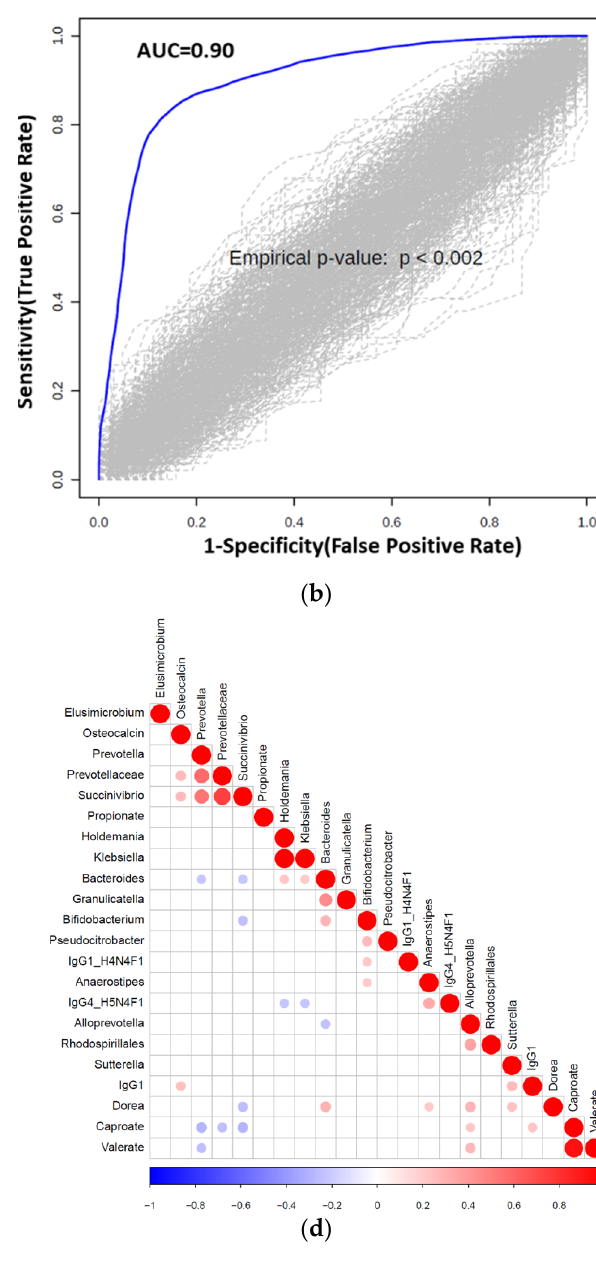
Figure 4. ( a ) Principal component analysis (PCA) score plot performed on the selected omics features demonstrating clustering of the rural vs. urban cohorts. Dots represent patients and are coloured according to the subject cohort. Ellipse represents 95% confidence. Results are plotted according to the Principal component-1 (PC1) and Principal component-2 (PC2) scores, with the percent variation of the cohort explained by the respective x and y axes. ( b ) Permutation test to show the stability of the AUC value after randomizing the urban and rural samples 100 times. ( c ) Significant correlation ( p < 0.05) heatmap of the elastic net selected features is shown for urban samples. ( d ) Significant Pearson correlation ( p < 0.05) heatmap of the elastic net selected features is shown for rural ( n = 94) samples.